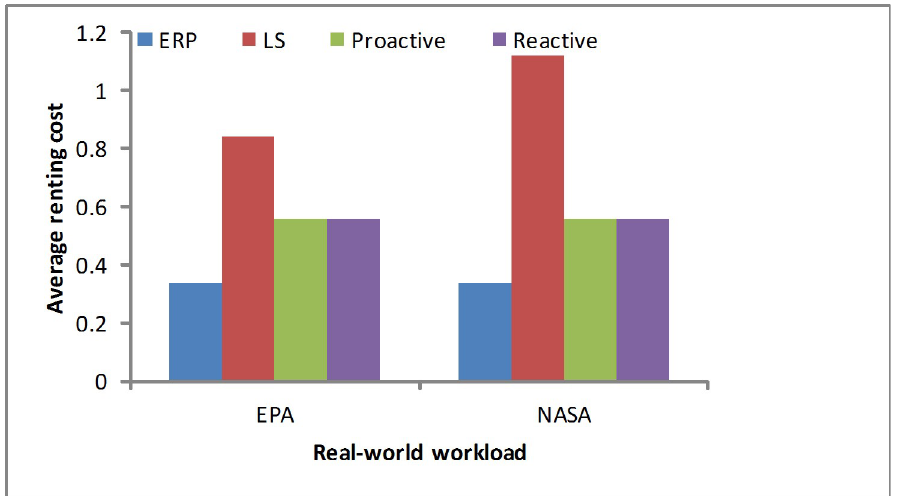
Fig 9. Average renting cost in the real-world workloads.